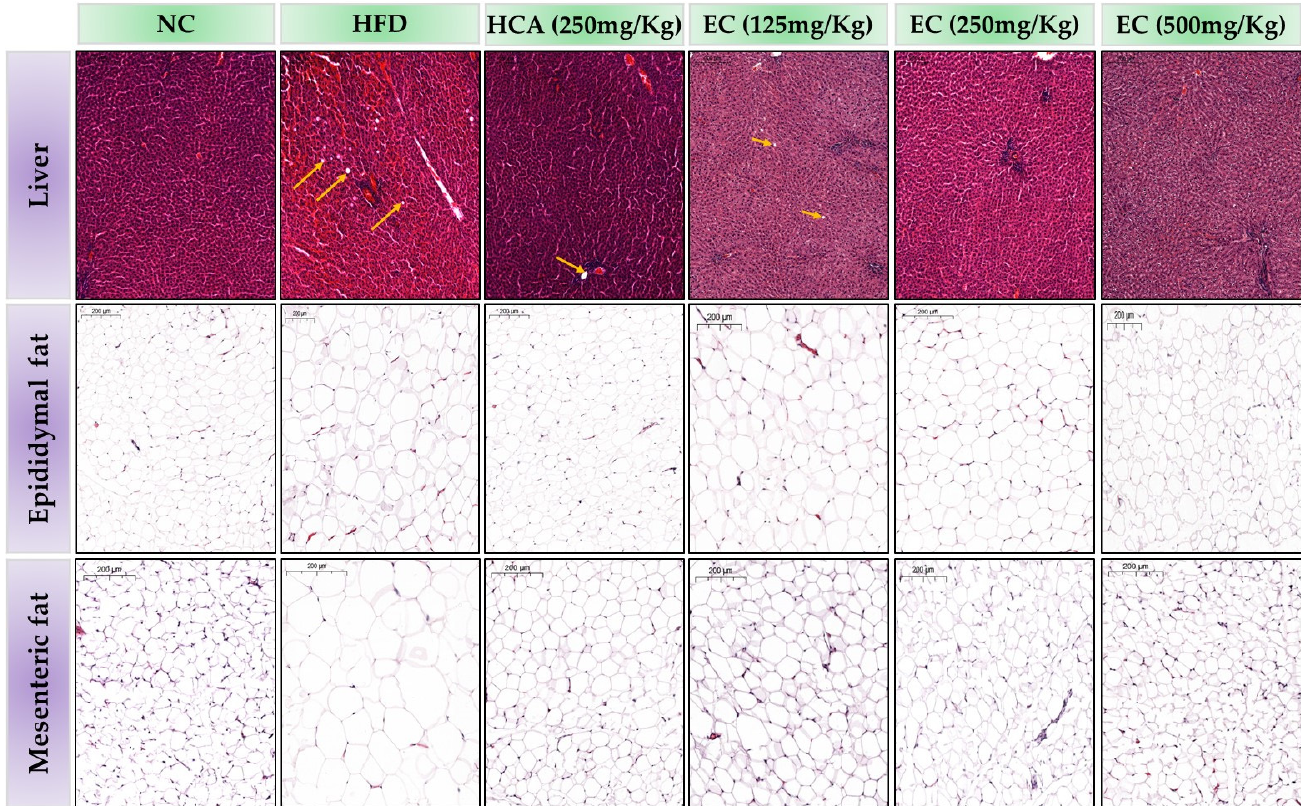
Figure 10. The effects of Ecklonia cava (EC) extract on adipocyte accumulation in hepatic tissue, epididymal, and mesenteric adipose tissues (hematoxylin and eosin staining, 10 × magnification). The figure shows hepatic tissue, epididymal and mesenteric adipose tissues (from top to bottom) from different groups, including normal diet group (NC), a high-fat diet group (HFD), or groups fed with EC-HFD at different doses of 125 mg (T1), 250 mg (T2), and 500 mg (T3) per kg B.W (moving from left to right). An image of the hepatic tissue of a rat from the HFD group shows fewer/absence of lipid droplets (yellow arrow) in treated groups as compared to the high-fat diet group. Moreover, adipose tissue histology shows a small-sized large number of adipocytes in treated groups as compared to the high-fat diet group.